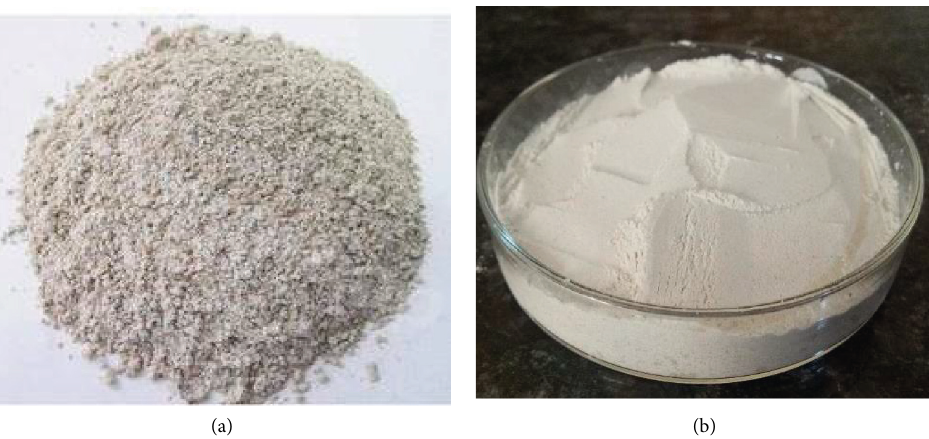
Figure 3: Identified industrial waste GBFS before and after milling: (a) as-received GBFS and (b) milled